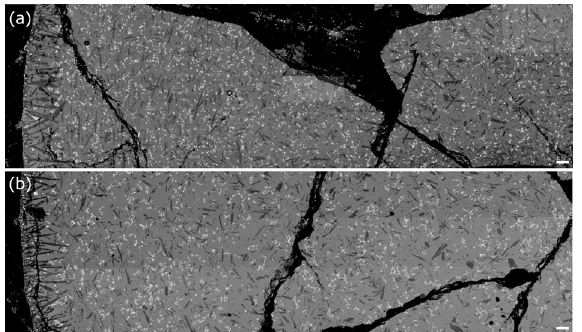
Figure 3. Back-scattered electron images of cross-sectional surfaces of samples cut off at a height of 13 mm from the bottom. The dark gray and elongated rectangles are plagioclase, the white crystals are Fe-Ti oxide, and the background is melt/glass. The scale bars in the lower right corners are 200 μm. Each figure is a composite image in which 27 images are superimposed. ( a ) Unaged sample with t pr = 10 min and ˙ γ pr = 0 s −1 . ( b ) Shear-aged sample with t pr = 60 min and ˙ γ pr = 0.02 s −1 .